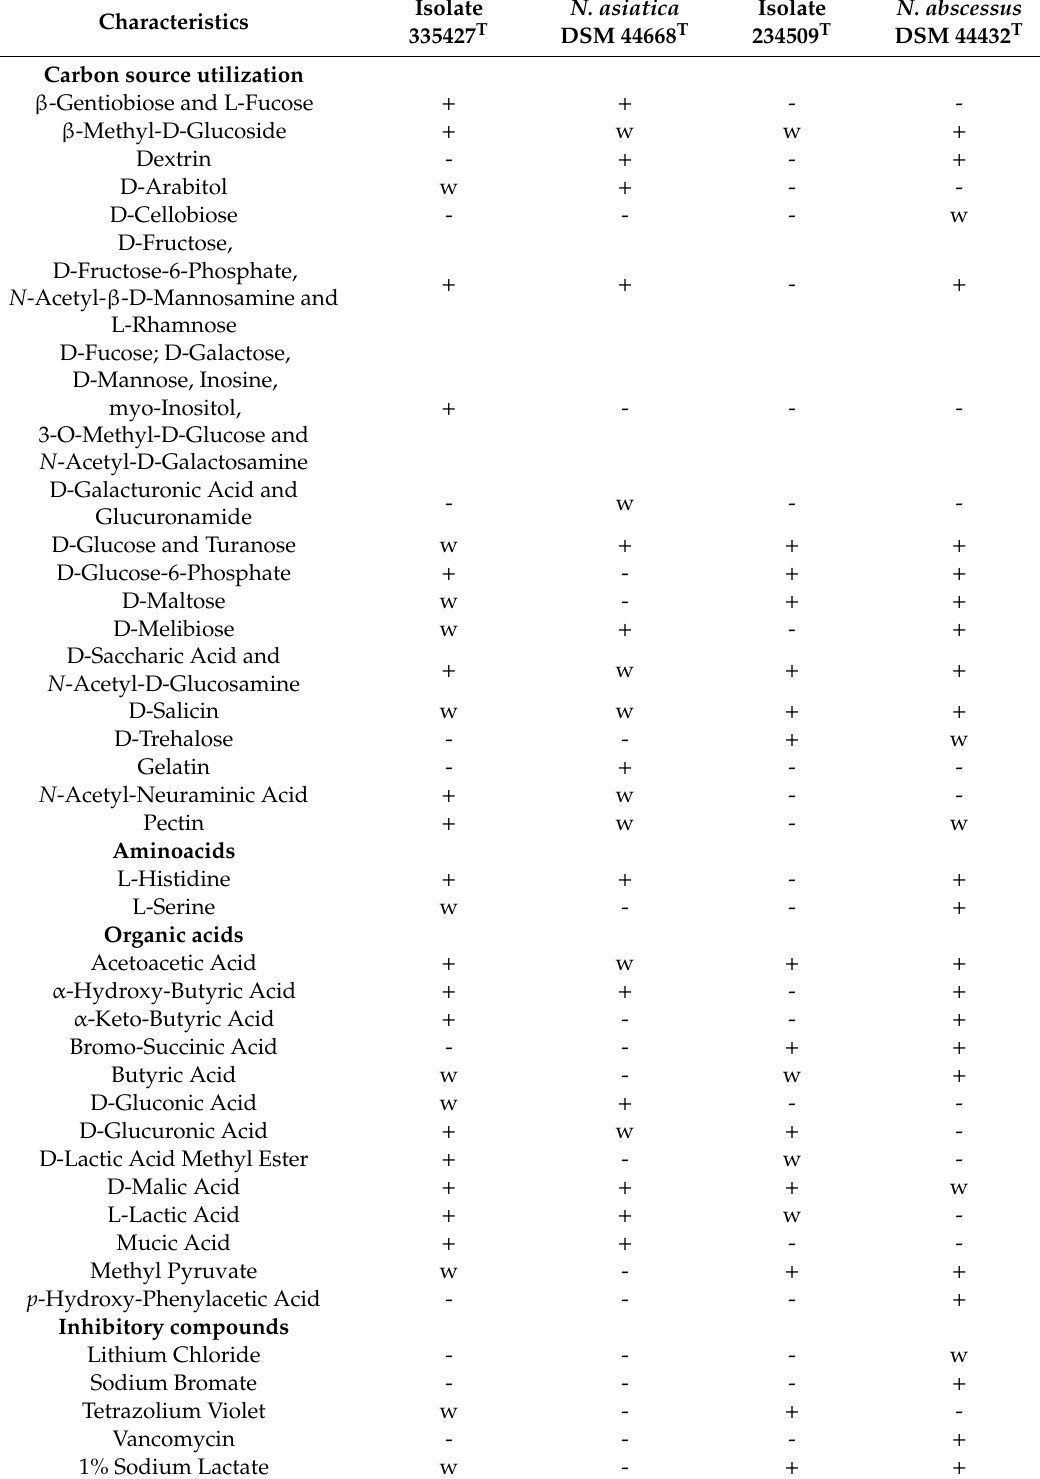
Symbols : + , Positive reaction; w, weak reaction; -, Negative